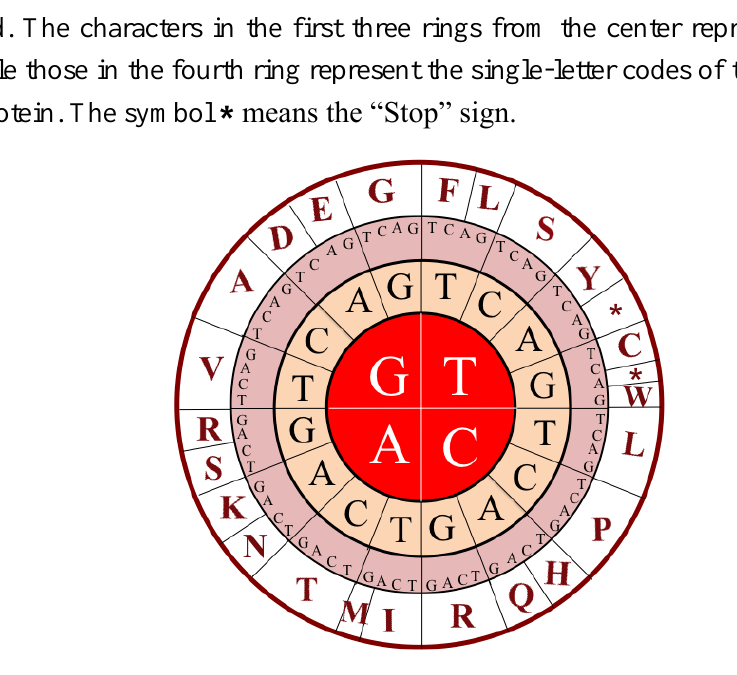
Table 1. The conversion code of the 64 trinucleotides in DNA to the 20 amino acids in